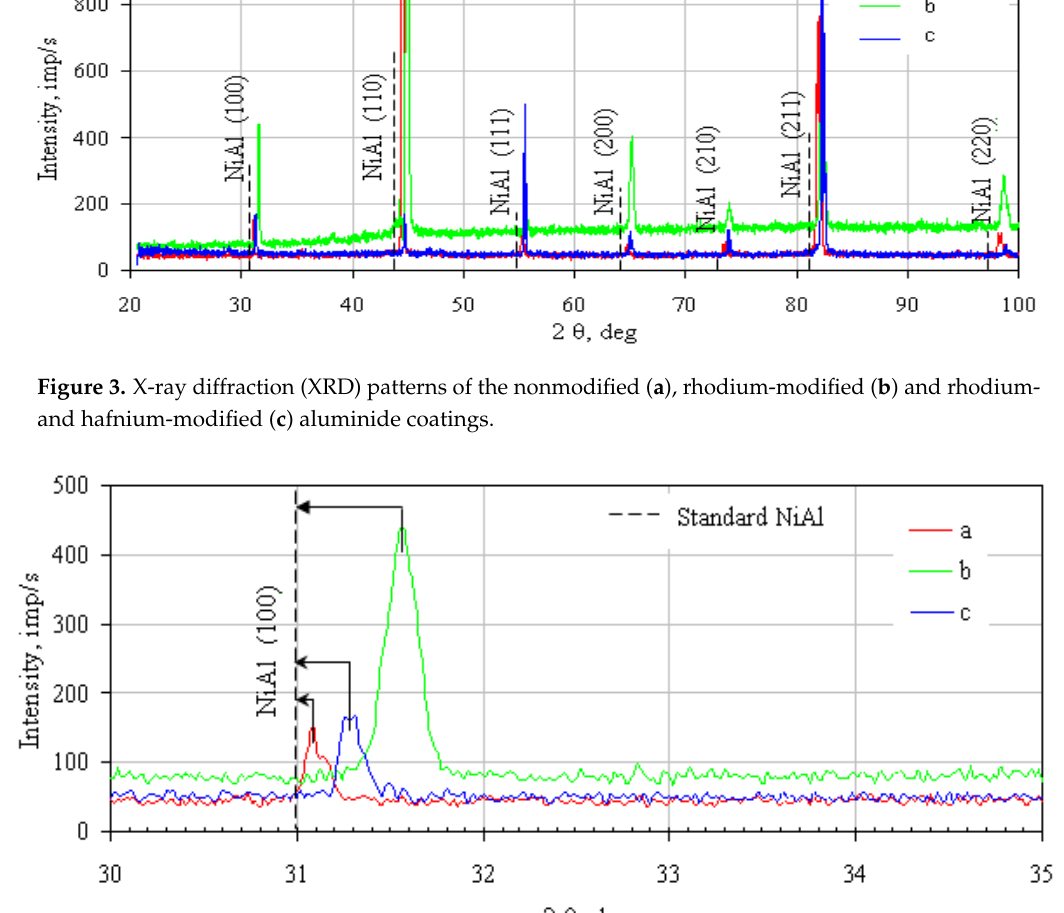
Figure 4. XRD shifts of the NiAl (100) reflection of the nonmodified ( a ), rhodium-modified ( b ) and rhodium- and hafnium-modified ( c ) aluminide coatings.